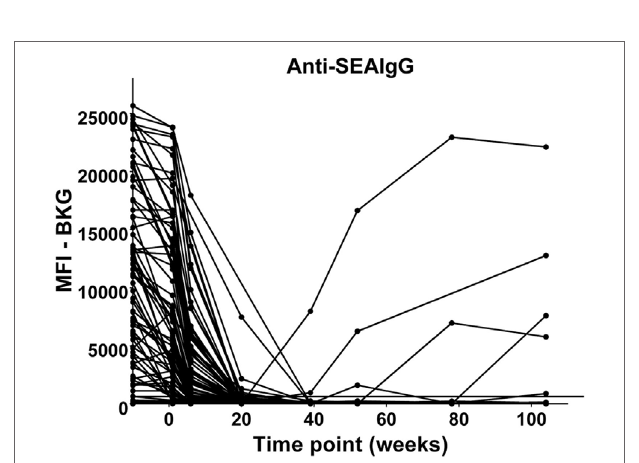
FigUre 4 | Time course of IgG antibody responses to Ascaris suum hemoglobin (AsHb) (a) and SsNIE (B) among infants from birth to 2 years. x -Axis shows time of sample collection, calculated from birth in weeks. Maternal antibody response is shown at − 10 weeks. Neonatal first bleed is shown at 1 week and subsequent bleeds are at 6 weeks and 5, 9, 12, 18, and 24 months. MFI, median fluorescence intensity; BKG,